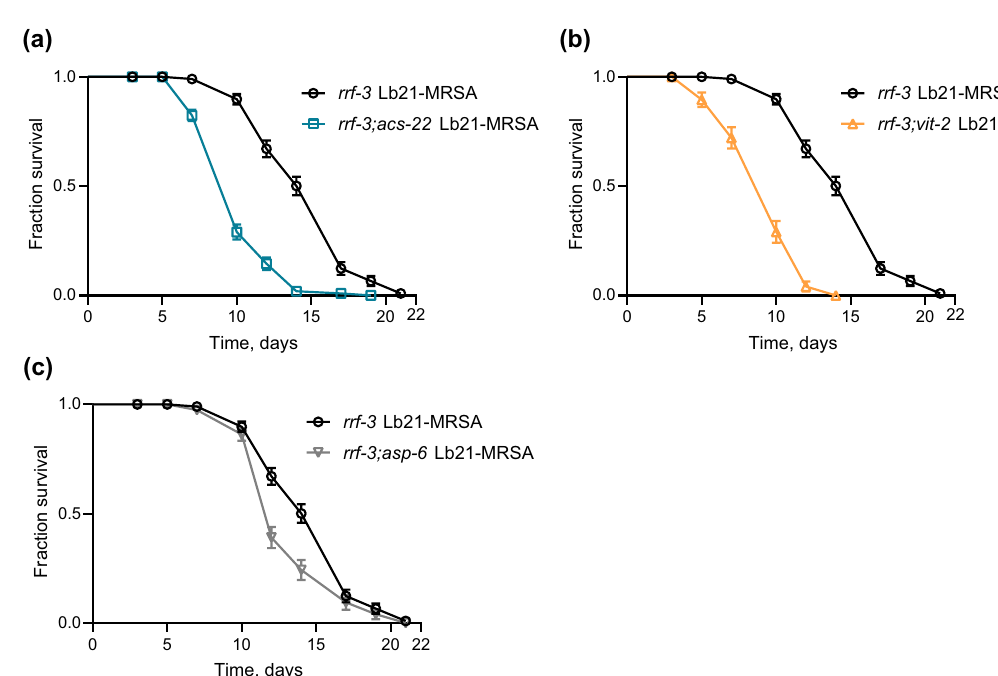
Figure 5. acs-22 , vit-2 and asp-6 are important for the host response to Lb21. ( a ) Double mutant rrf-3(pk1426); acs-22 ( tm3236 ) pretreated with Lb21 before MRSA challenge compared to rrf-3(pk1426) pretreated with Lb21 before MRSA challenge. ( b ) Double mutant rrf-3(pk1426);vit-2 ( ok3211 ) pretreated with Lb21 before MRSA challenge compared to rrf-3(pk1426) pretreated with Lb21 before MRSA challenge. ( c ) Double mutant rrf- 3(pk1426);asp-6 ( tm2213 ) pretreated with Lb21 before MRSA challenge compared to rrf-3(pk1426) pretreated with Lb21 before MRSA challenge. See Table S1 for additional